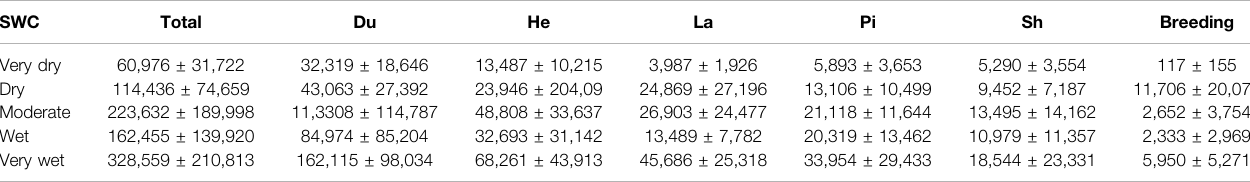
TABLE 1| Average annual water bird abundance (Nos +/ − SD)from the Eastern Australia Waterbird Survey (EAWS) acrossthe Murray-DarlingBasin (1983 – 2020), strati fi ed by fi veSurfaceWaterConditions(SWC)andseparatedintototalnumbers,the fi vefunctionalresponsegroups(Du-ducks;He-herbivores,La-largewaders,Pi-piscivores, Sh-shorebirds) and total waterbird